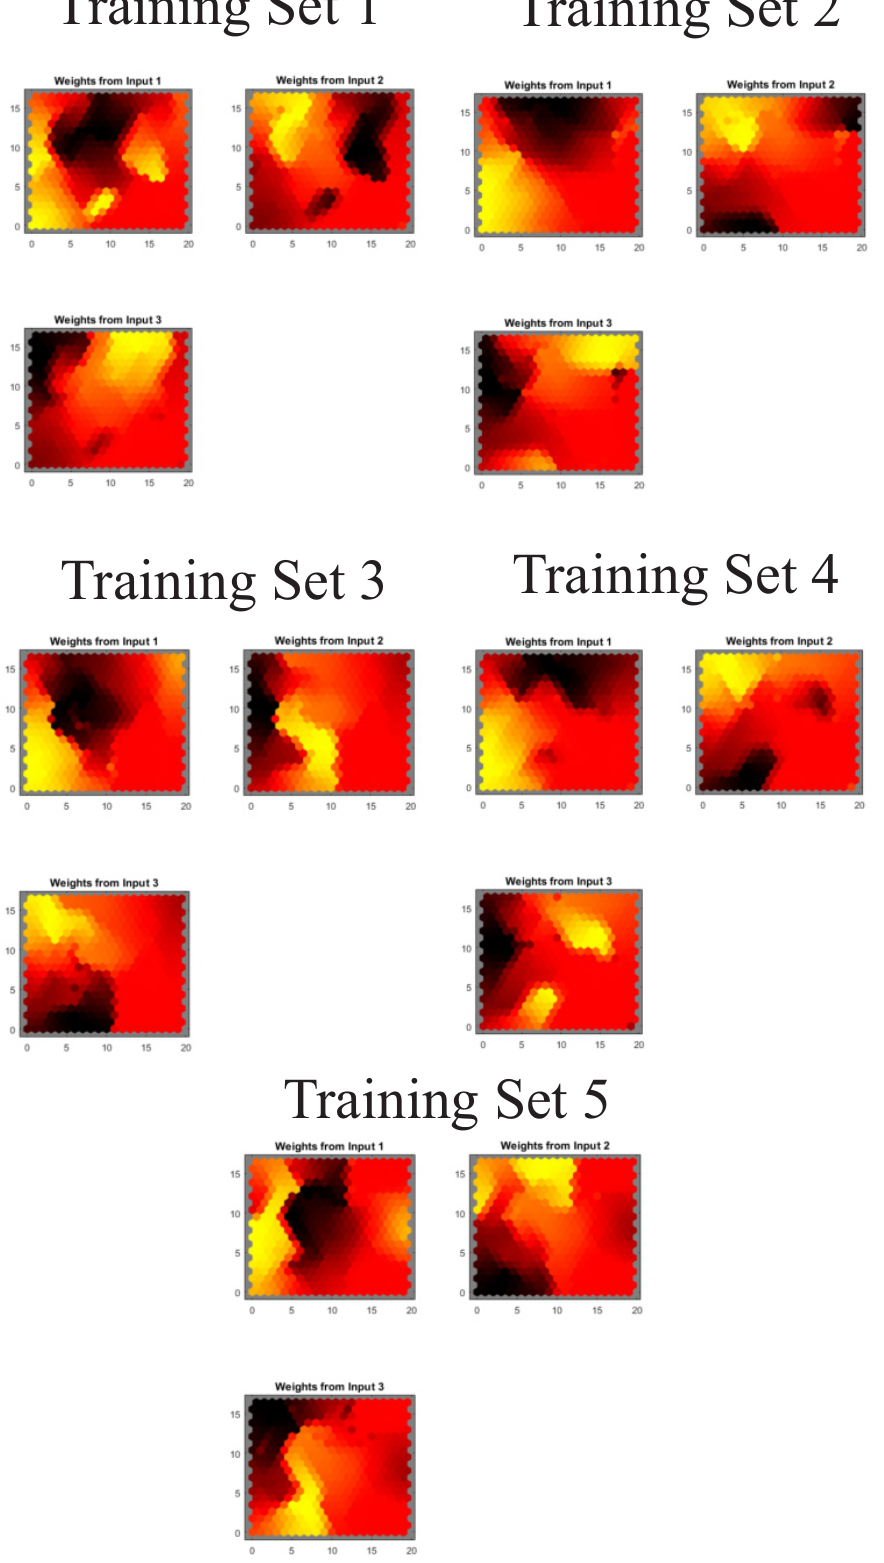
Figure 12. Self Organizing Map (SOM) input planes per phase of the system in a 20 × 20